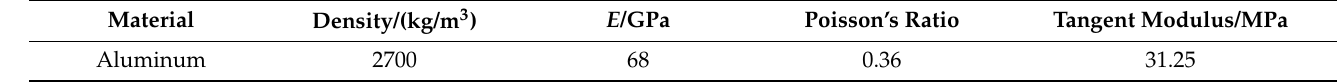
Table 1. Material parameters of aluminum in the numerical model.